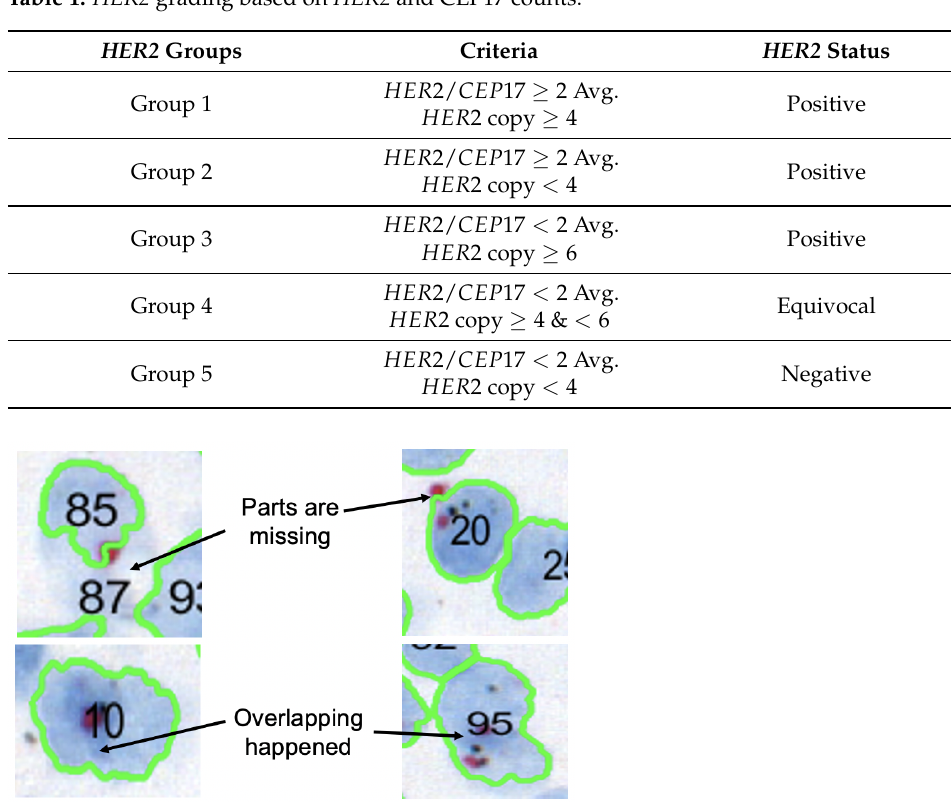
Figure 3. False positives of singular nuclei which may lead to inaccurate signal